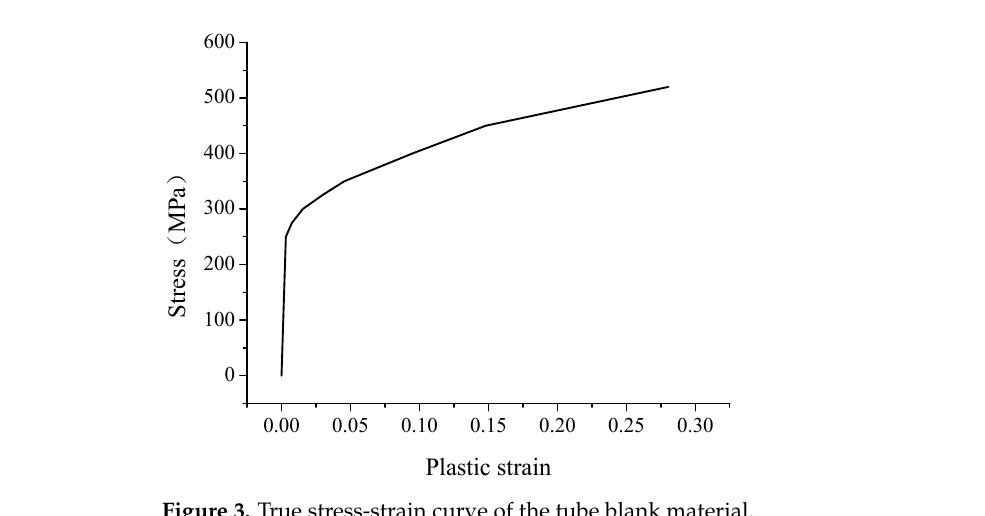
Figure 3. True stress-strain curve of the tube blank material.